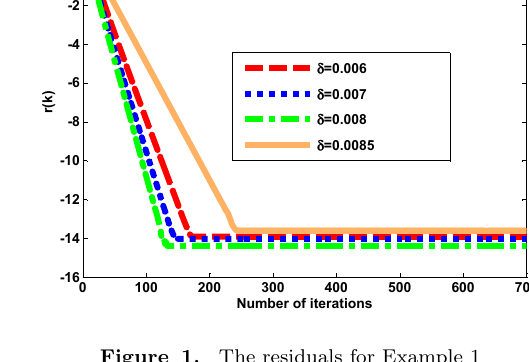
Figure 1. The residuals for Example